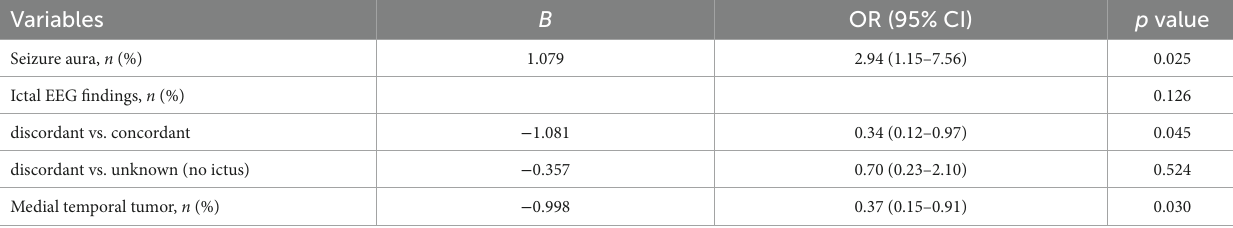
TABLE 2 Multivariate analysis of the relationships between CD34 expression in GG and clinicopathology in 208 patients. Variables B OR (95%